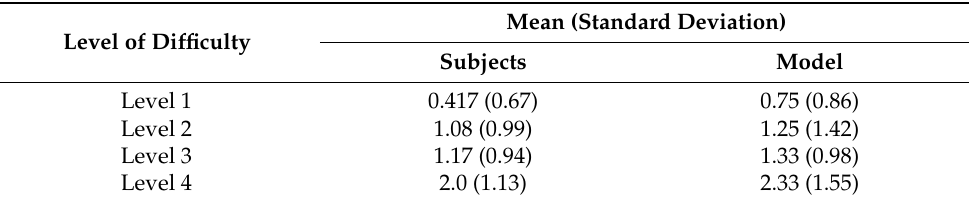
Figure 7. Average number of task switching occurrences during the execution of a subtask in the memory game for the subject and model data. Table 4. Mean of task switching during the execution of a subtask for subjects and model data.